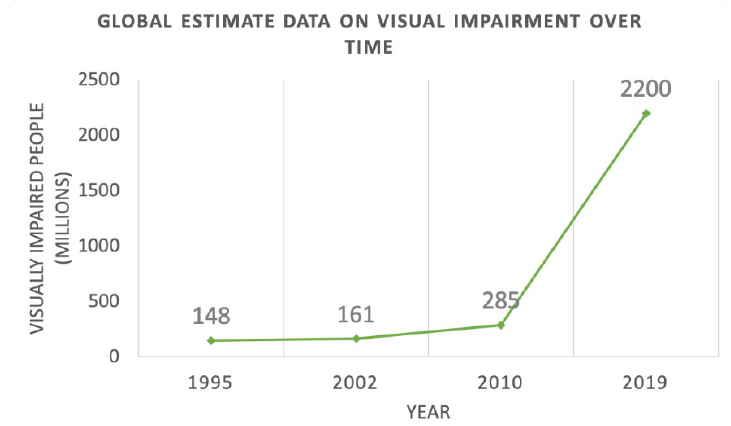
Figure 1. Chart showing the estimated number of people with some type of visual impairment in the world over the years, according to WHO data (Thylefors et al., 1995; Resnikoff et al., 2004; Word Heath Organization 2012,